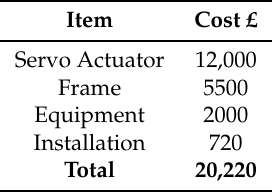
Table 1. Machine